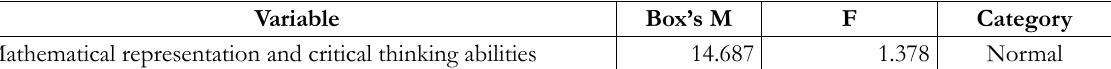
Table 14. Result of homogeneity test